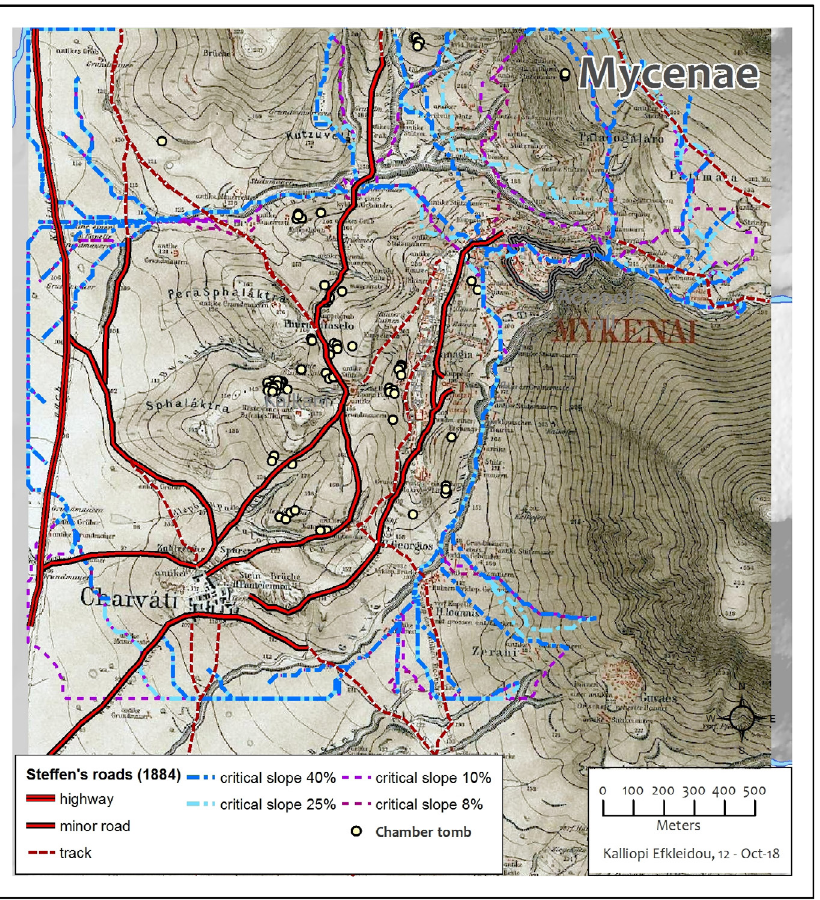
Figure 10 . The optimal LCPs based on various critical slope rasters and the 19th century C.E. road network in the hinterlands of